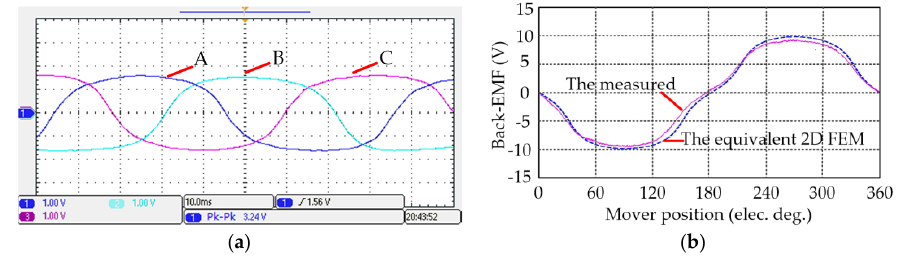
Figure 17. The measured no-load back-EMF: ( a ) The phase; ( b ) The line.